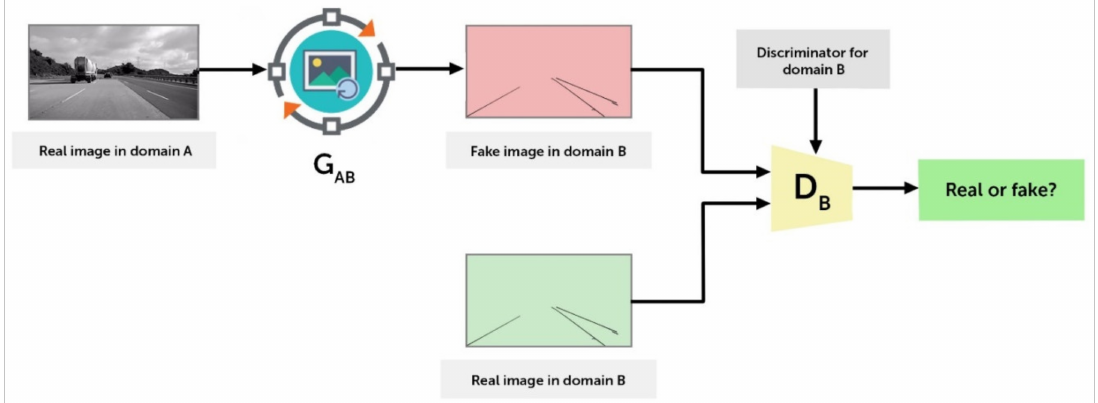
Figure 3. Block diagram of ICGA architecture.